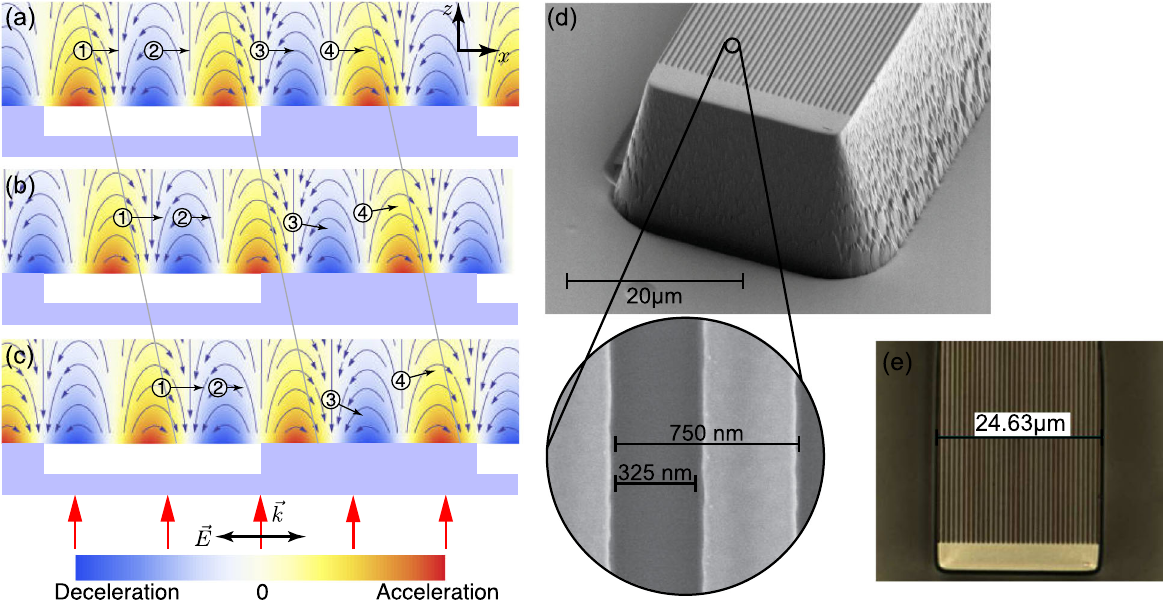
FIG. 1 (color online). (a – c) Three consecutive snapshots in time (a quarter optical period apart) of the electric field distribution of the third spatial harmonic (blue arrows) above a grating (light blue structure). This surface wave, excited by a linearly polarized laser from below (red arrows), propagates synchronously with the charged particles (numbered circles) along the grating surface. Here the charged particles are assumed to be positrons. Depending on the relative position of the positron inside the field the force can lead to either acceleration (1), deceleration (2), or deflection (3,4), as indicated by the blue arrows and the color shading. (d) Electron microscope image of the fused silica grating that is located on top of a mesa, 20 μ m above the substrate. The closeup shows the grating with a grating ¼ 750 nm, a trench width of 325 nm, and a depth of 280 nm. (e) Top view of the mesa with a width of 25 μ period λ p